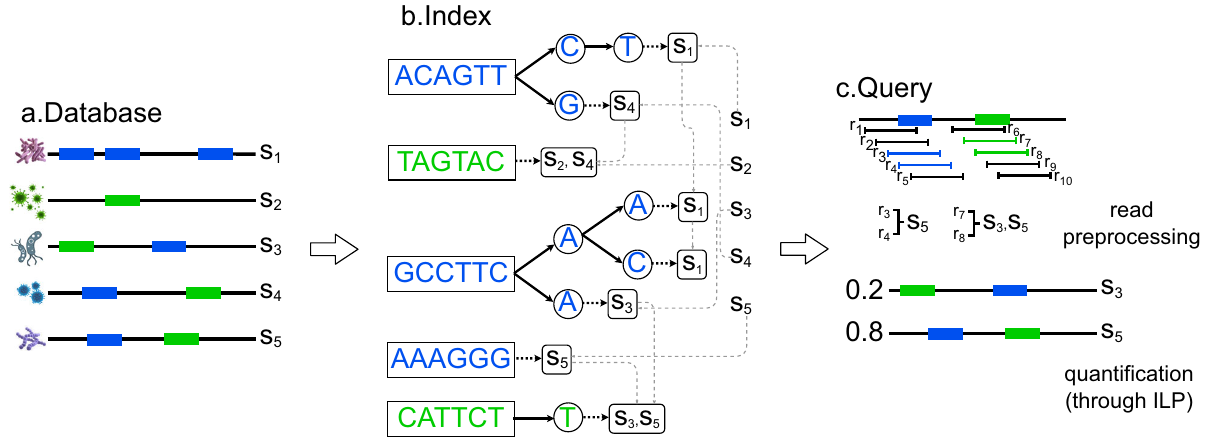
Fig. 3 | Overview of CAMMiQ ’ s index structure. Strings in blue are unique substrings and those in green are doubly-unique